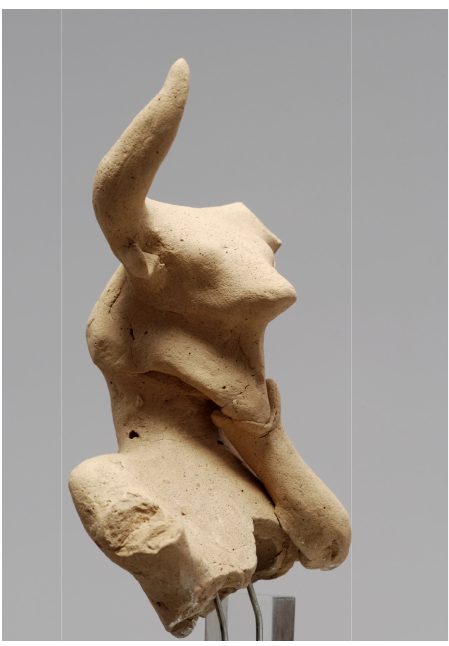
Figure 5. Terracotta statuette of a human wearing a bull mask, A.I. 809, © Medelhavsmuseet.